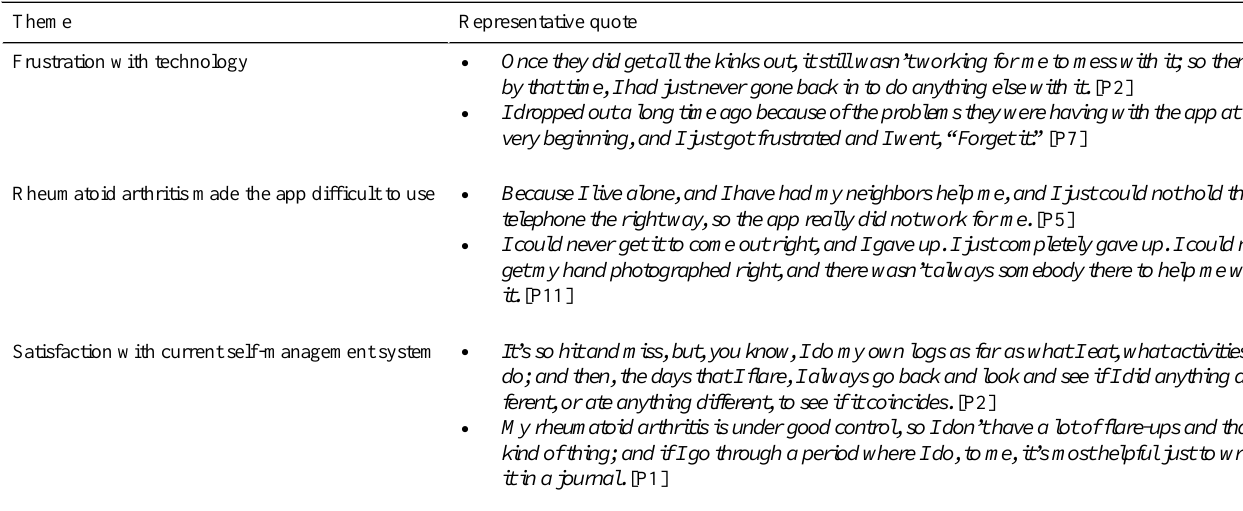
Table 2. Qualitative themes and representative